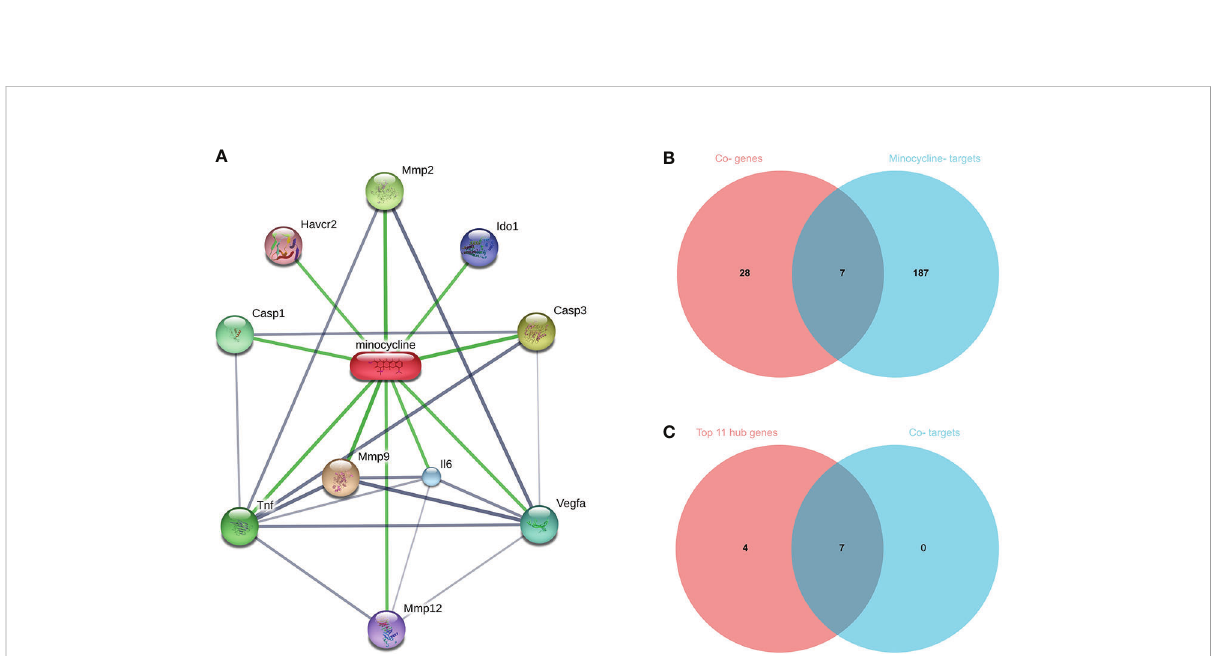
FIGURE 9 (A) Network diagram of minocycline and related target genes on the STITCH platform, with minocycline in capsules and related target genes in circles. (B) Venn-diagram of Co-genes versus minocycline-targets. (C) Venn diagram of the top 11 hub genes versus Co-targets, with Co-targets all contained in the top 11 hub genes.